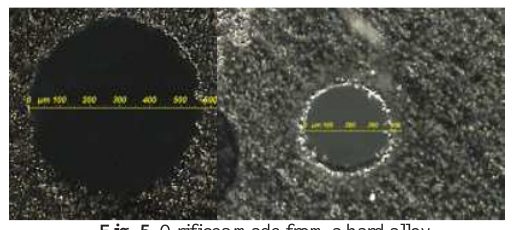
Fig. 5. Orifices made from a hard alloy